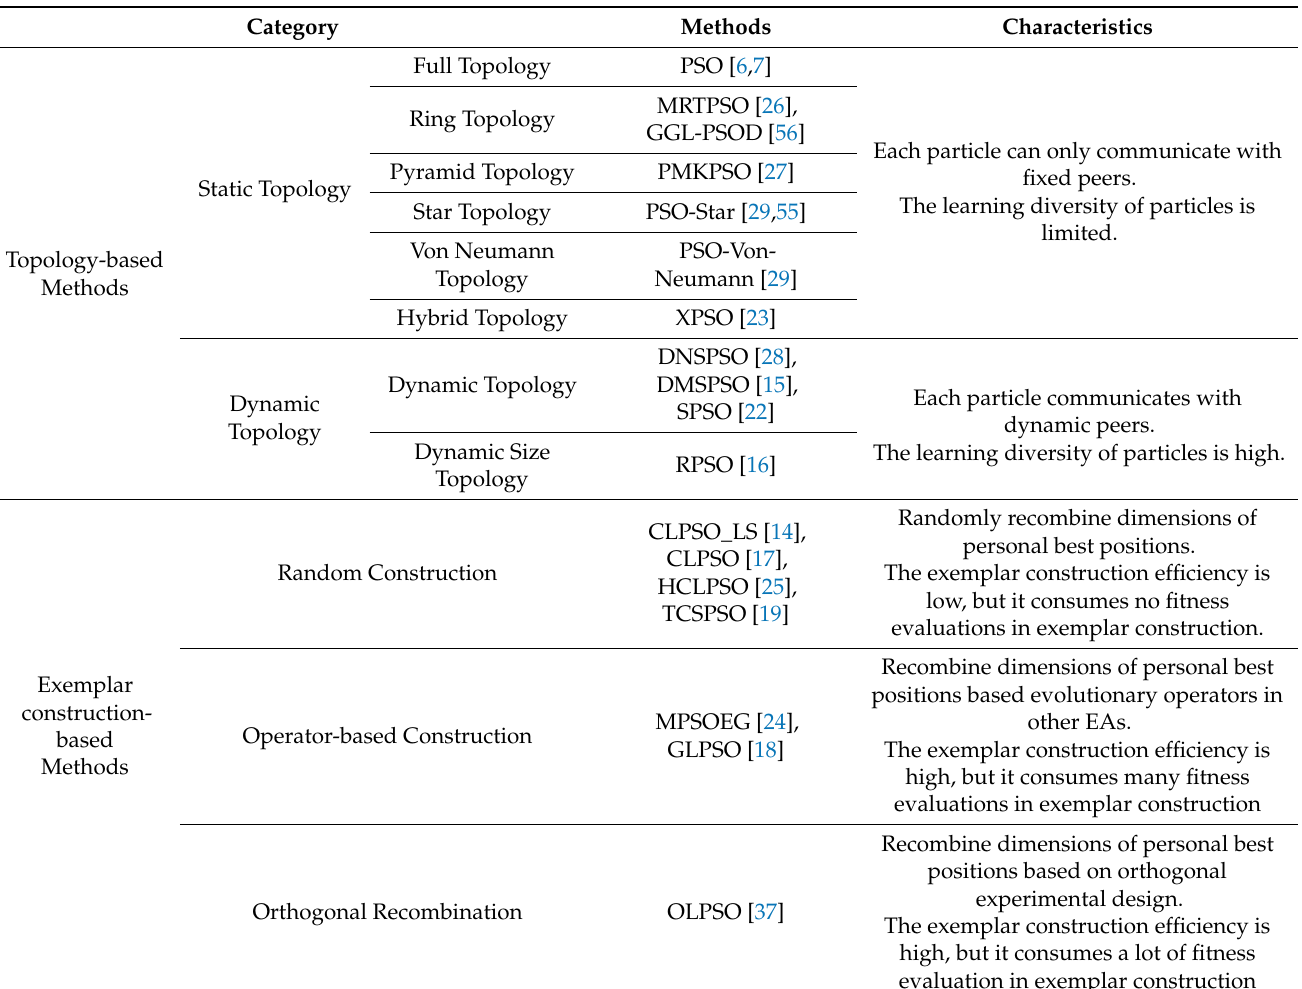
Table 1. The rough classification of existing PSO